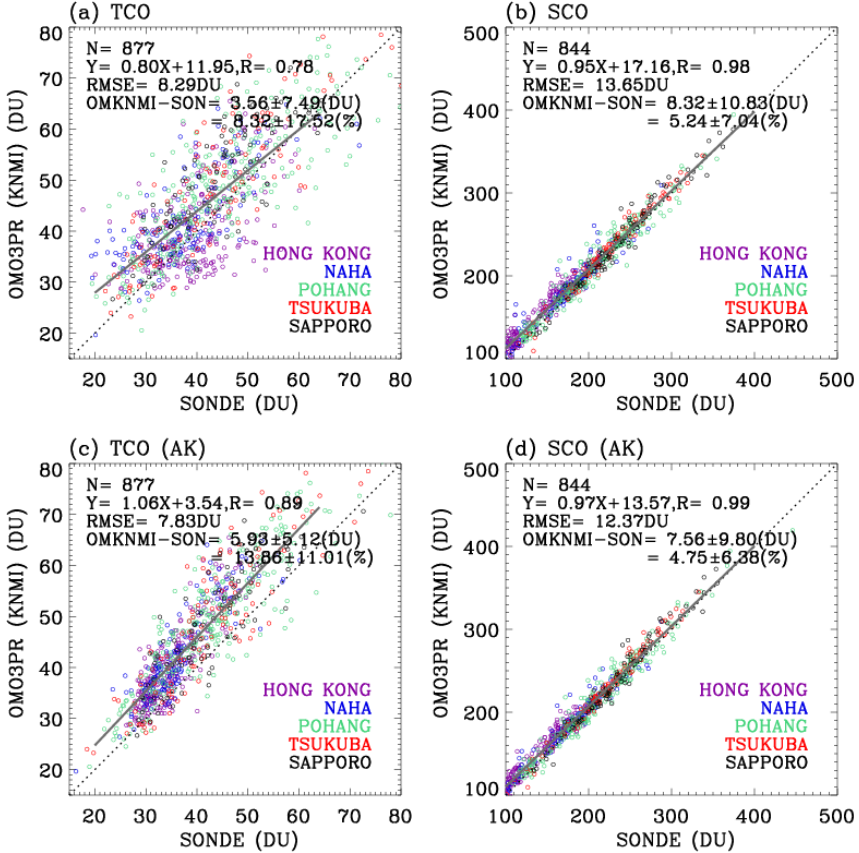
Figure 9. Same as Fig. 8 but for validating OMI standard ozone profiles (OMO3PR) produced by the KNMI OE-based algorithm.